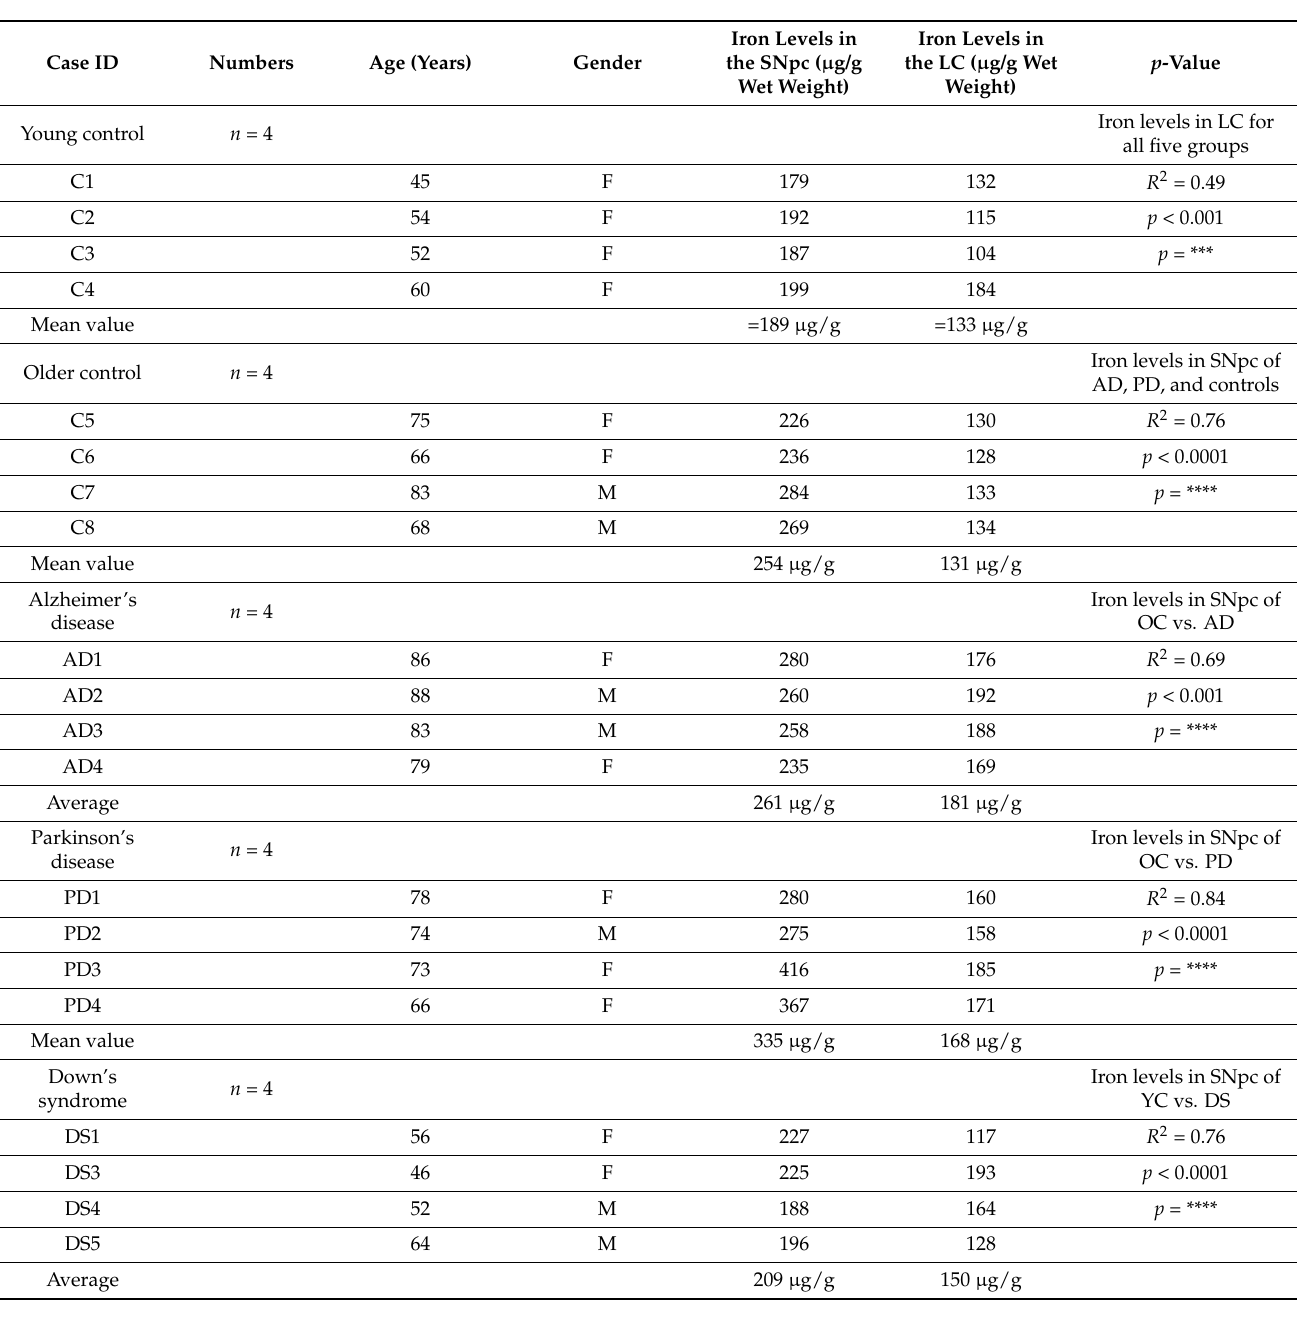
Table 2. Data were analysed by paired Student’s t -test (two-tailed) for two group comparison, or by ANOVA test for multiple comparison testing. Values in the figures are expressed as mean ± SEM. A one-way ANOVA was used for comparison of data among control, PD, AD, and DS. Significance was analysed using GraphPad and p -values ≤ 0.001 were considered significant, *** = p < 0.001, **** = p <